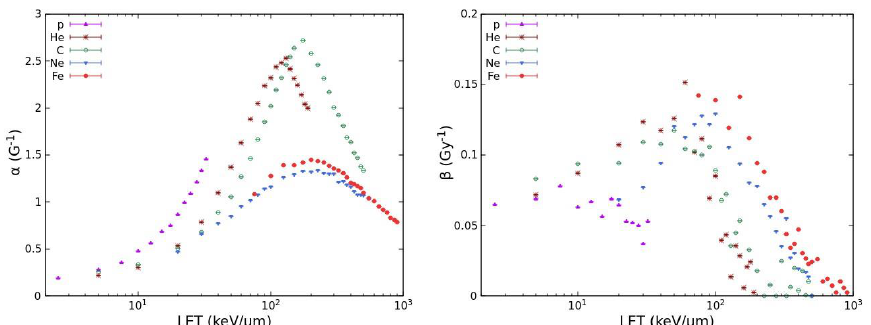
Fig. 1. Values of the coefficients ɑ (left panel) and β (right panel) describing HSF cell survival as a function of LET for the different ion beams considered in this work.